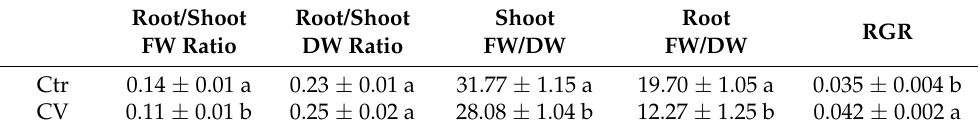
Table 2. Growth parameters of lettuce seedlings subjected to Chlorella vulgaris extract treatment (CV) by foliar application after 21 days from the first treatment. Data are means ± SD. The values are the means of data from five plants for each replica. Values in the same column followed by different letters are significantly different ( p < 0.05). Ctr: control; FW: fresh weight; DW: dry weight; RGR: Relative Growth Rate.